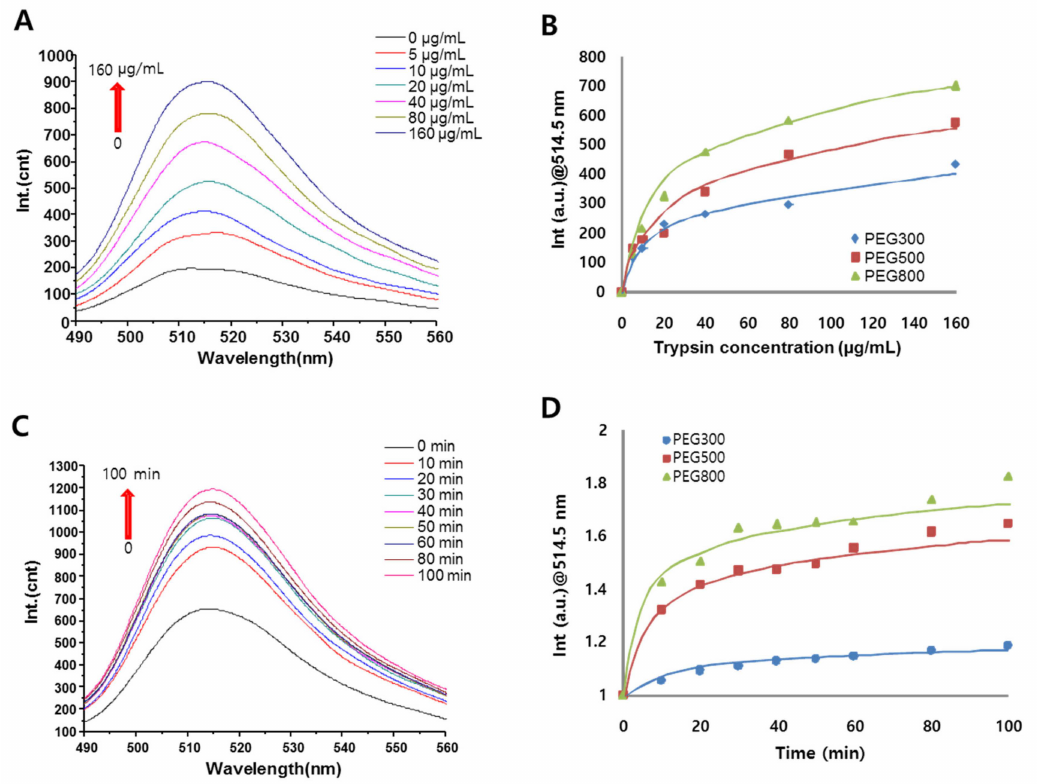
Figure 5. Fluorescence signals from fluorescein 5-isothiocyanate FITC-KKK PEGx-MGO biosensors upon tryptic peptide cleavage. ( A ) Fluorescence emission spectra of FITC-KKK-PEG 800 -MGO FRET biosensors in the presence of trypsin at concentrations of 0 to 160 µ g / mL for 30 min. ( B ) Fluorescence intensity recovery (F / F 0 ) at 514.5 nm depending on the PEG length in FITC-KKK-PEGx-MGO in response to di ff erent concentrations of trypsin. ( C ) Temporal fluorescence emission spectra of FITC-KKK-PEG 800 -MGO FRET biosensors from 0 to 100 min with 20 µ g / mL of trypsin. ( D ) Time-dependent fluorescence intensity recovery (F / F 0 ) at 514.5 nm depending on PEG length in FITC-KKK-PEGx-MGO with 20 µ g / mL of